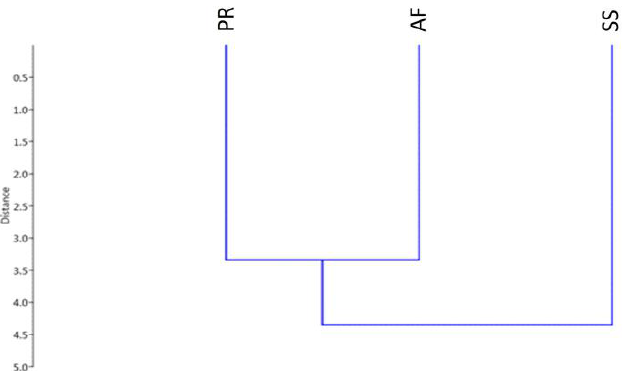
Figure 3. Cluster analysis of local populations in the study based on qualitative data. Local population code: PR = Prizzi; AF = Alcara Li Fusi; SS = S. Stefano Quisquina.